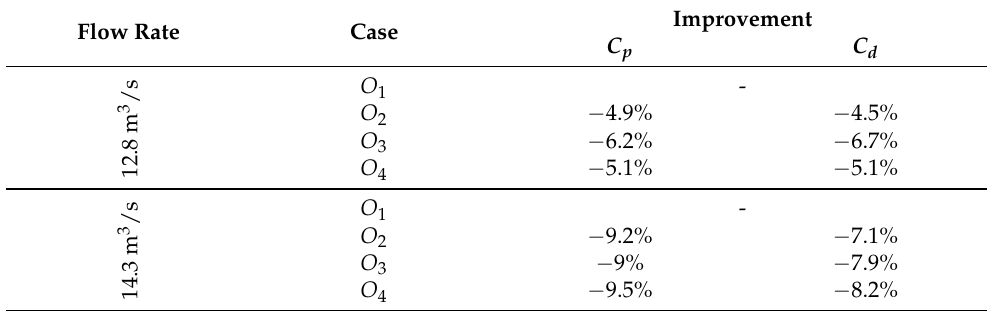
Table 9. Geometry improvements for different flow